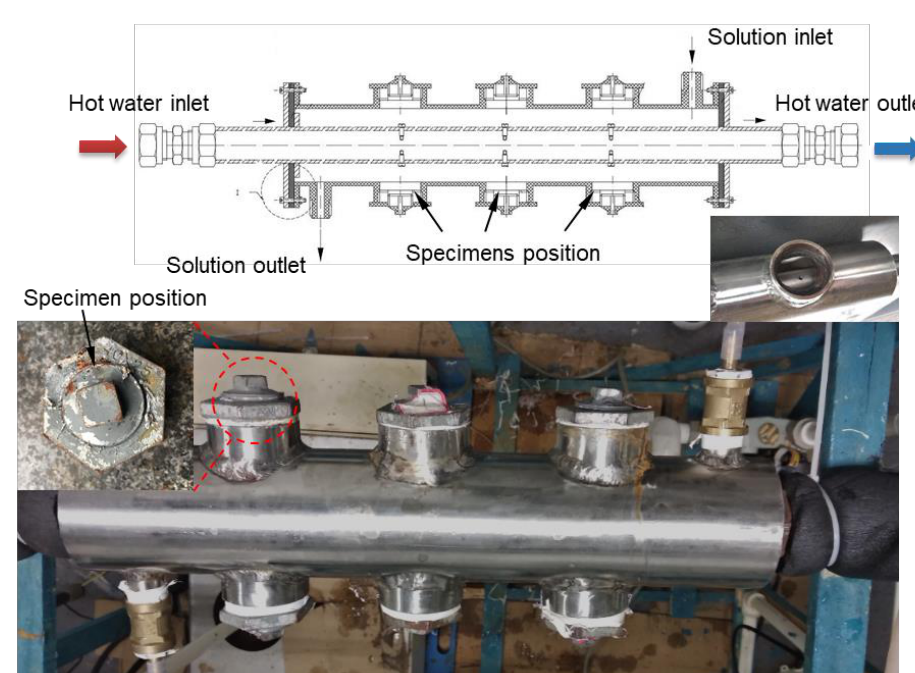
Figure 3. Measurable anti-fouling heat exchanger.